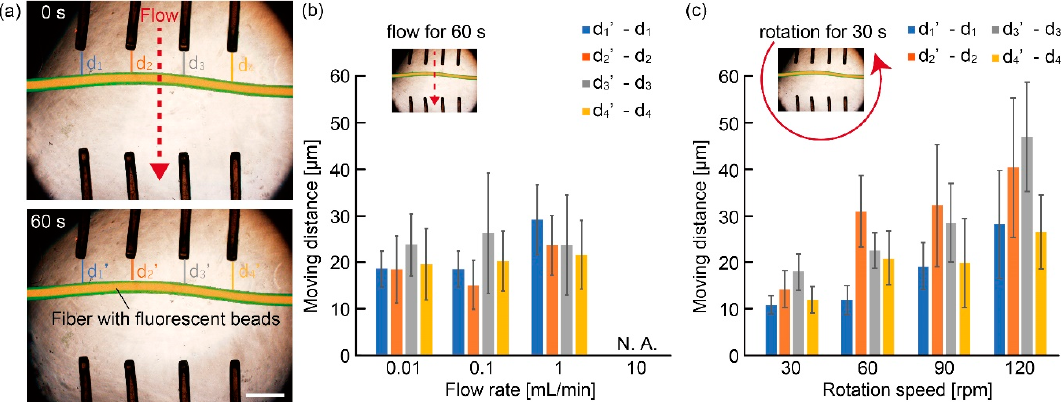
Figure 5. Evaluation of immobilization of a microfiber with fluorescent beads with the anchoring device: ( a ) Images of the microfiber before and after applying a 1 mL/min flow in the device; ( b , c ) Moving distance of the microfiber in the anchoring device when we applied ( b ) a flow and ( c ) a rotation to the device (N = 5, mean ± s. d.). Scale bar is 1 mm.